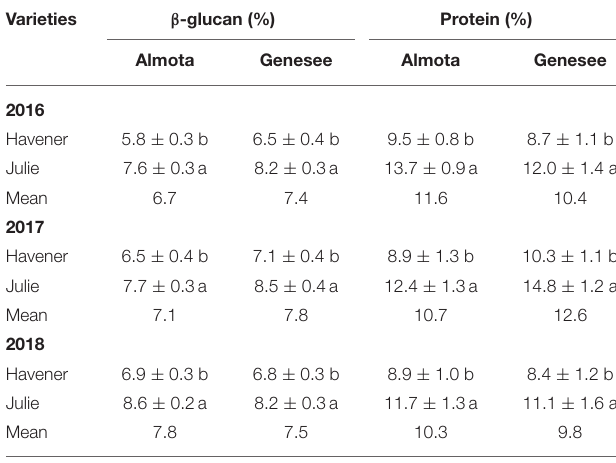
Dissimilar letters in a column are significantly different at p ≤ 0.05.